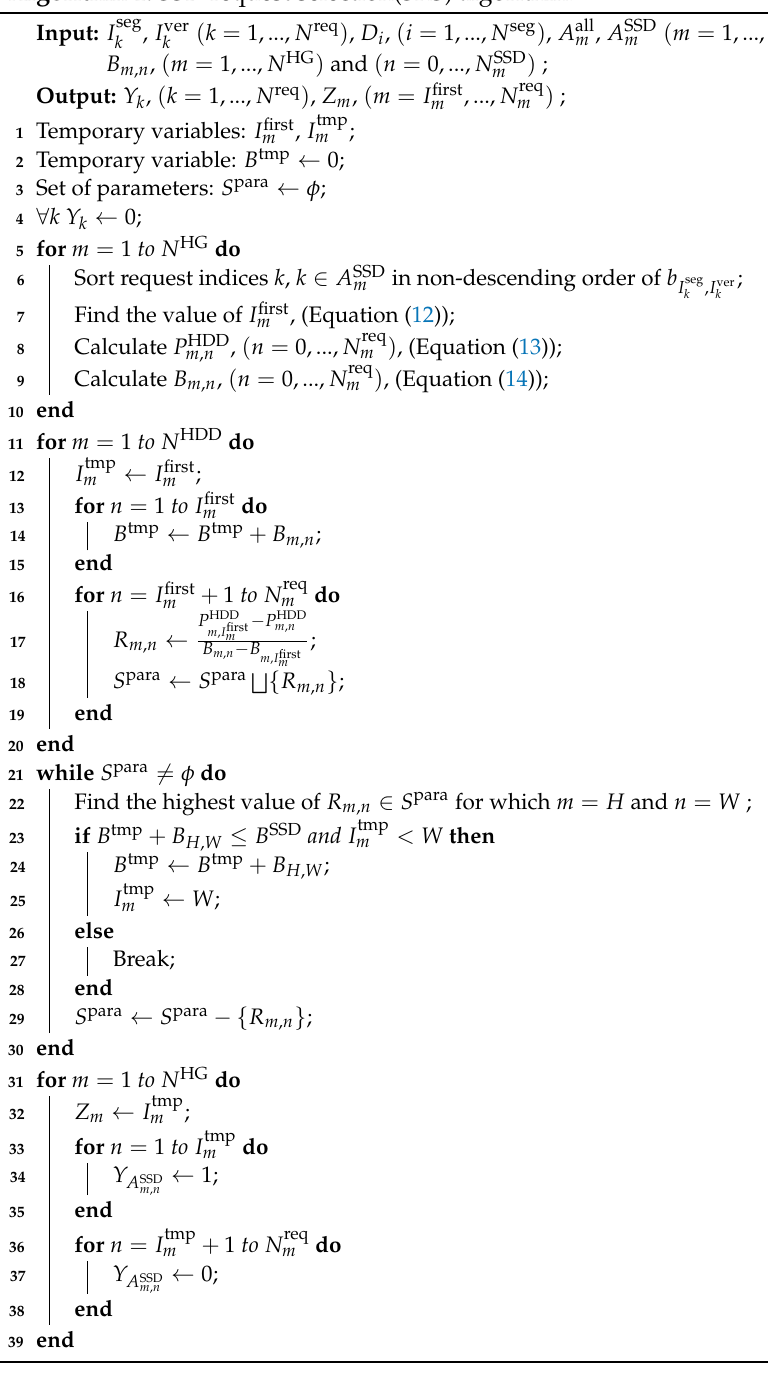
Algorithm 1: SSD request selection(SRS)